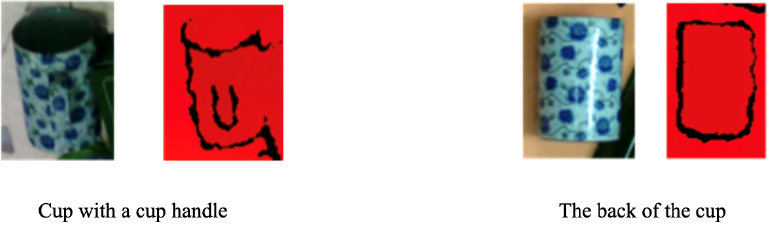
Figure 5. Objects with the same textures and different shapes, the left object is a cup with a handle and the right object is another side of the cup with the handle hidden. The depth image is next to the color image.